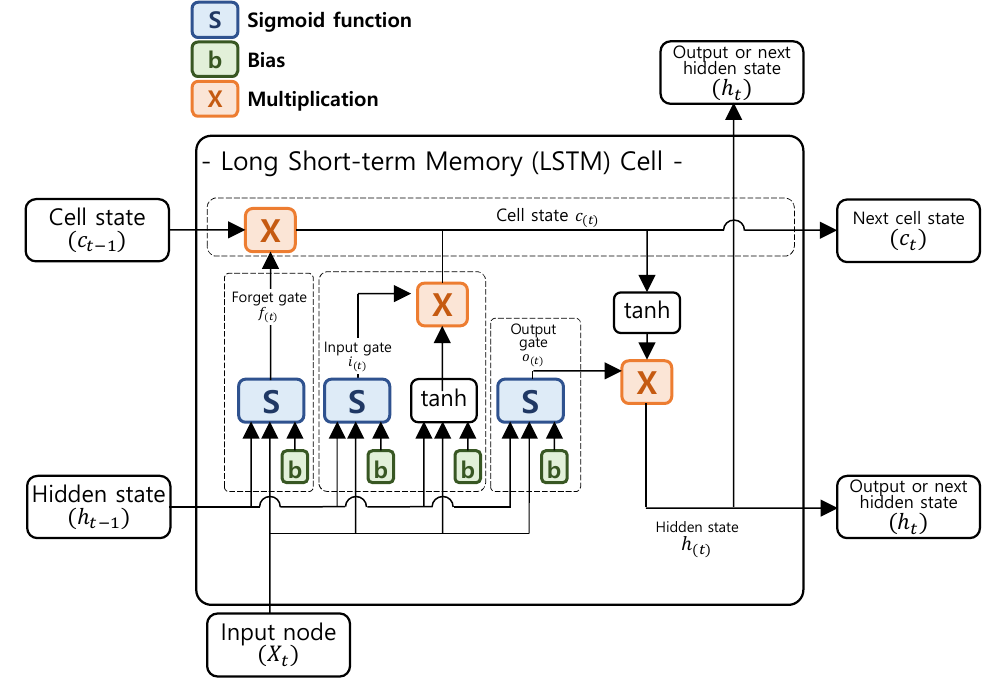
Figure 8. Structure of an LSTM cell.